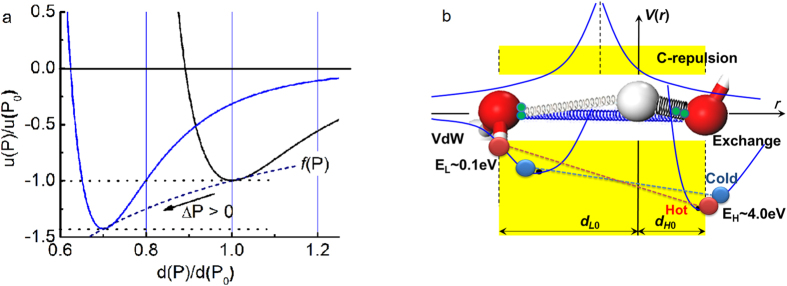
(a) The long-range, mono-well potential for paring atoms in a ‘normal’ substance and (b) the asymmetrical, short-range, double-well potentials for the O:H-O bond and their relaxation dynamics4041. Compression stores energy by shortening and stiffening the bond whereas tension does the opposite, along an f(P) path in (a). O:H-O potentials include the O:H nonbond van der Waals like (vdW-like) interaction (EL ~ 0.1 eV, left-handed side), the H-O exchange interaction (EH ~ 4.0 eV, right-handed side), and the Coulomb repulsion (C-repulsion) between electron pairs (paring green dots) on oxygen ions. A combination of these interactions with external stimulus dislocates O atoms in the same direction by different amounts. The relaxation proceeds along the potential paths with respect to the H atom (in grey) coordination origin under compression (linked blue spheres-equivalent of cold) or tension (linked red spheres further moves left-equivalent of hot). Springs are analogous the respective interactions. The dH0 and dL0 in (b) are the respective segmental length references at 4 °C.